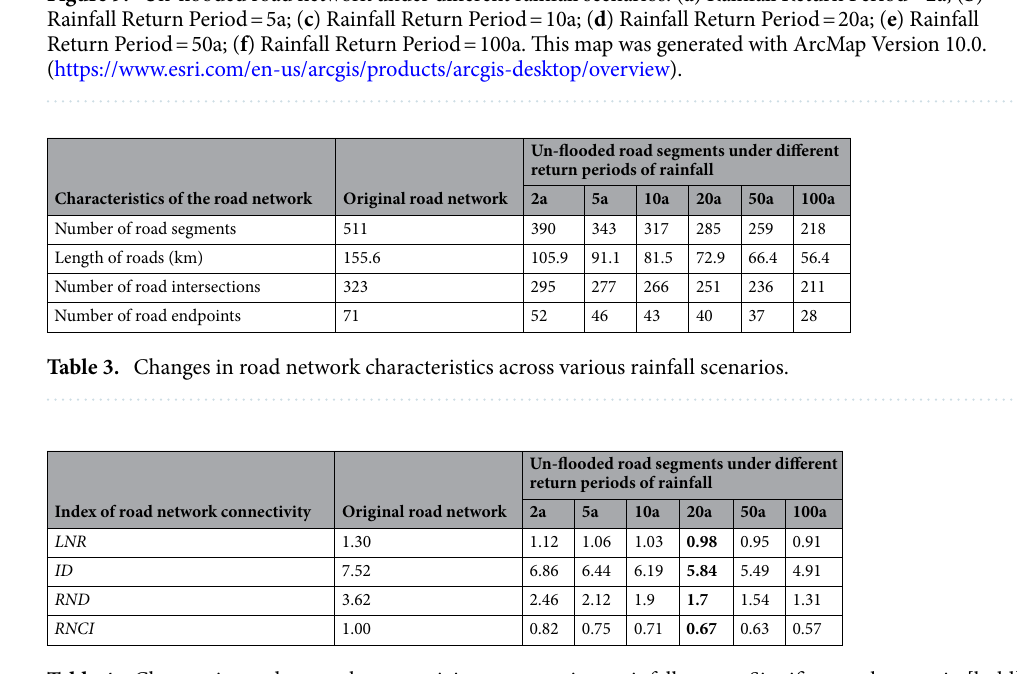
Table 4. Changes in road network connectivity across various rainfall events. Significant values are in